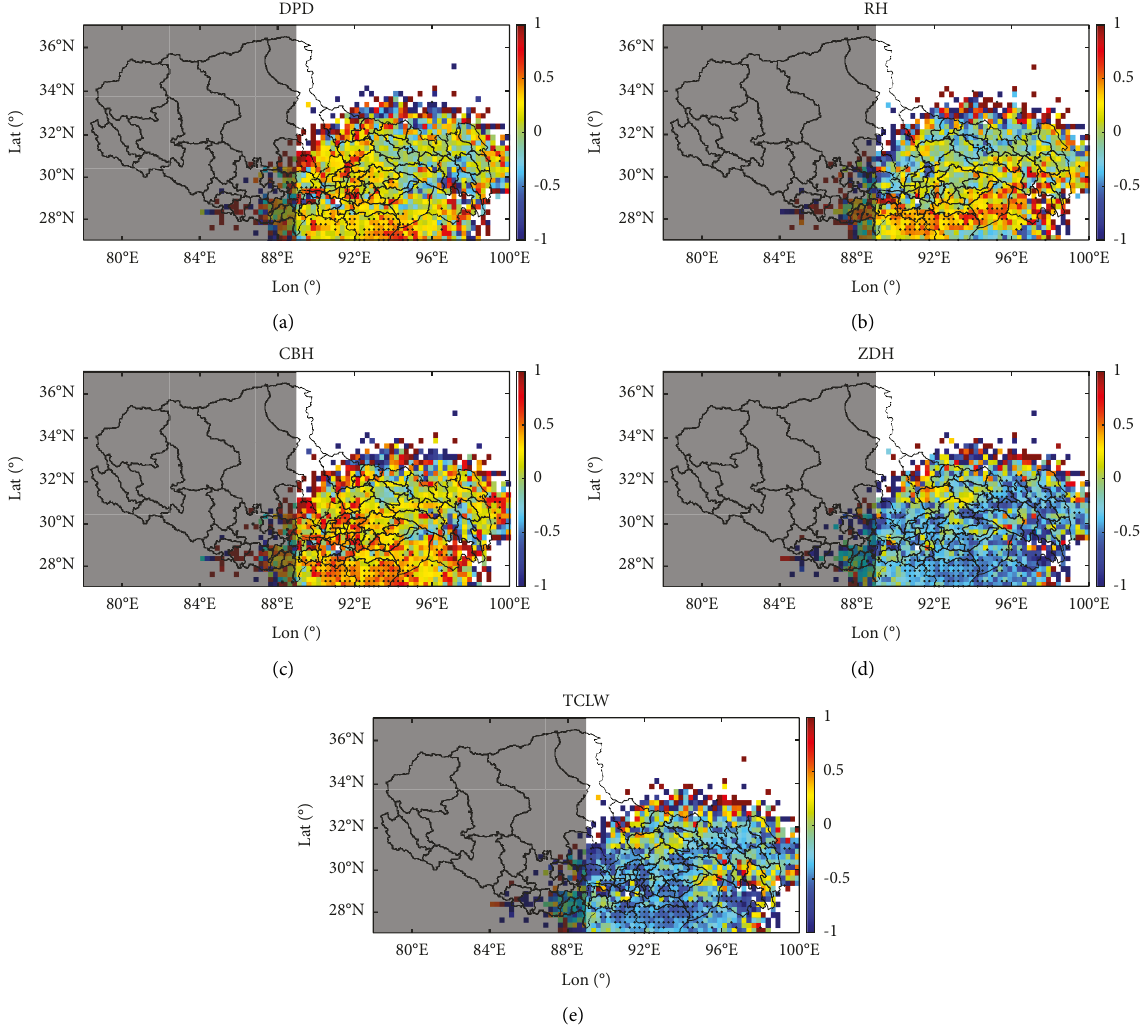
Figure 12: Correlation coefficients between the proportion of +CG (%) and (a) DPD (K), (b) RH (%), (c) CBH (m), (d) ZDH (m), and (e) TCLW (kg/m 2 ) between May and October. The correlation coefficients are calculated based on the monthly average data of 60 months, and the black dots indicate statistical significance at the 95% confidence